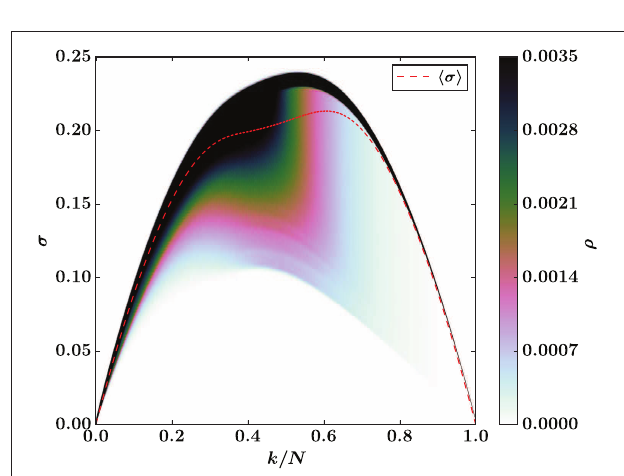
FIGURE 8 | The dashed, red line is the sample averaged load curve for the LLS model with a uniform threshold distribution on [0,1], Equation (7) with t 0 = 0. It is based on simulations on a square lattice ( N = 128 2 ). The background is a color map that shows the density ρ of single sample LLS load curves for the 1.5 × 10 5 samples that the average is based on. The color bar is capped at ρ = 0.0035 to highlight the fluctuations with the smallest values of σ